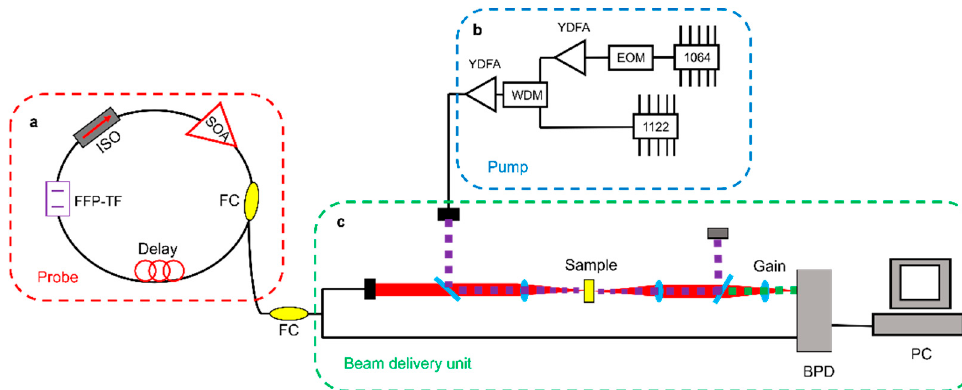
Figure 22. Schematic of the time-encoded Raman system. ( a ) The fibre based, wavelength-swept FDML probe laser25. FC, fibre coupler; FFP-TF, fibre Fabry- Pérot tuneable filter; ISO, optical isolator; SOA, semiconductor optical amplifier. ( b ) The homebuilt fibre-based pump laser is digitally synchronized to the FDML. EOM, electro-optic modulator; WDM, wavelength division multiplexer; YDFA, ytterbium-doped fibre amplifier. ( c ) The lasers are combined in the beam delivery unit and focused onto the sample. The SRG signal is detected after subtraction of the offset by a differential balanced photodetector (BPD). Adapted with permission from Ref. [165].